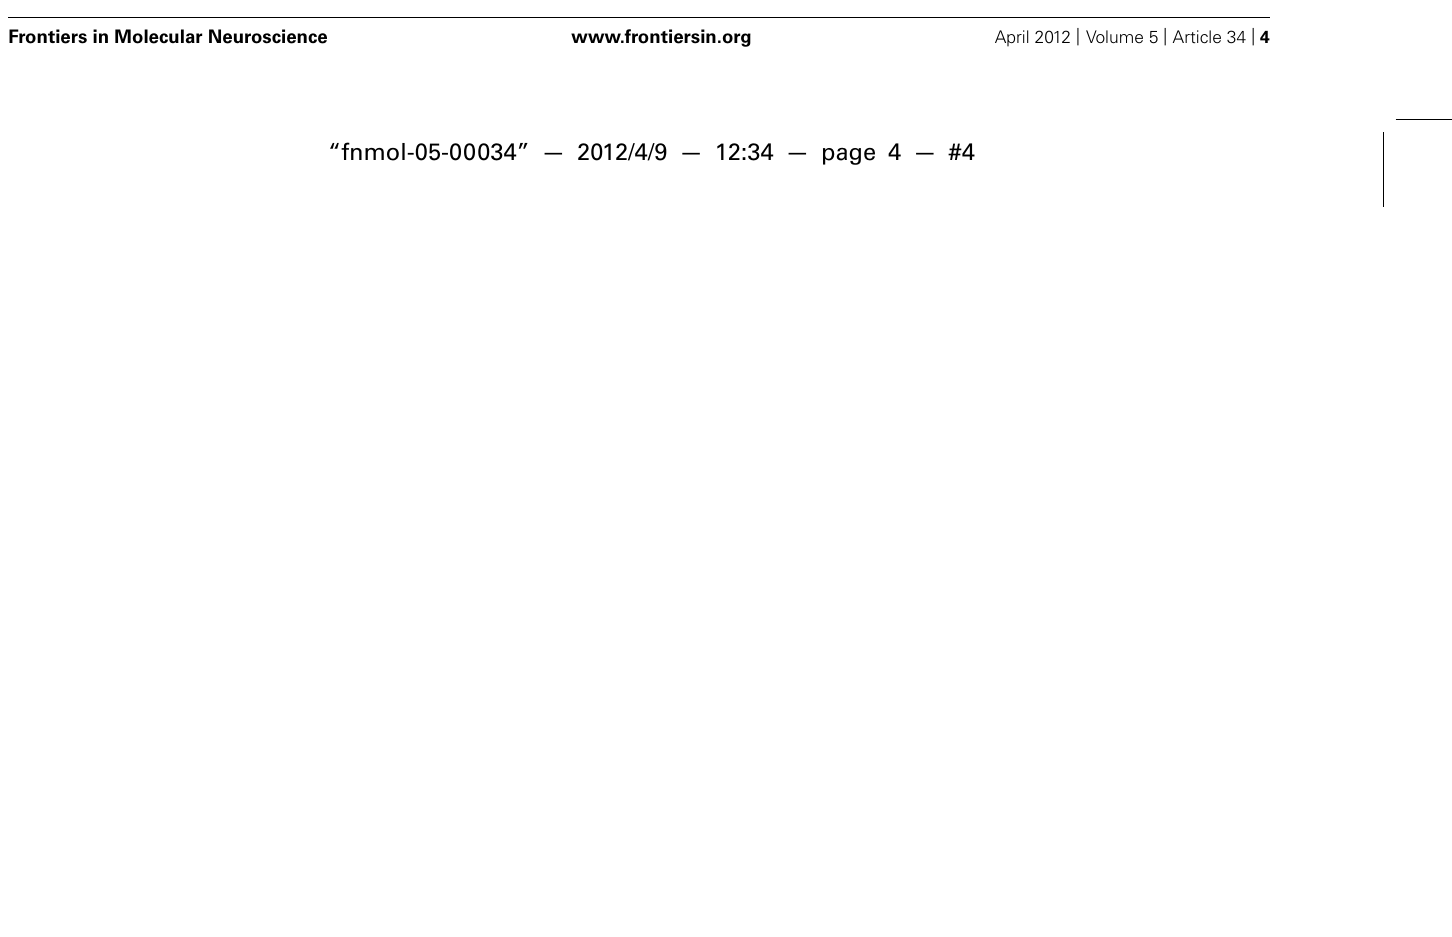
GluA2. Reprinted from Sobolevsky etal. (2009), with permission. (B) AMPA receptors generally contain GluA2 (red) with combinations of GluA1, GluA3, and GluA4 (blue). AMPA receptors containing edited GluA2 are impermeable to Ca 2 + (left). AMPA receptors containing unedited GluA2 and AMPA receptors lacking GluA2 are Ca 2 + -permeable